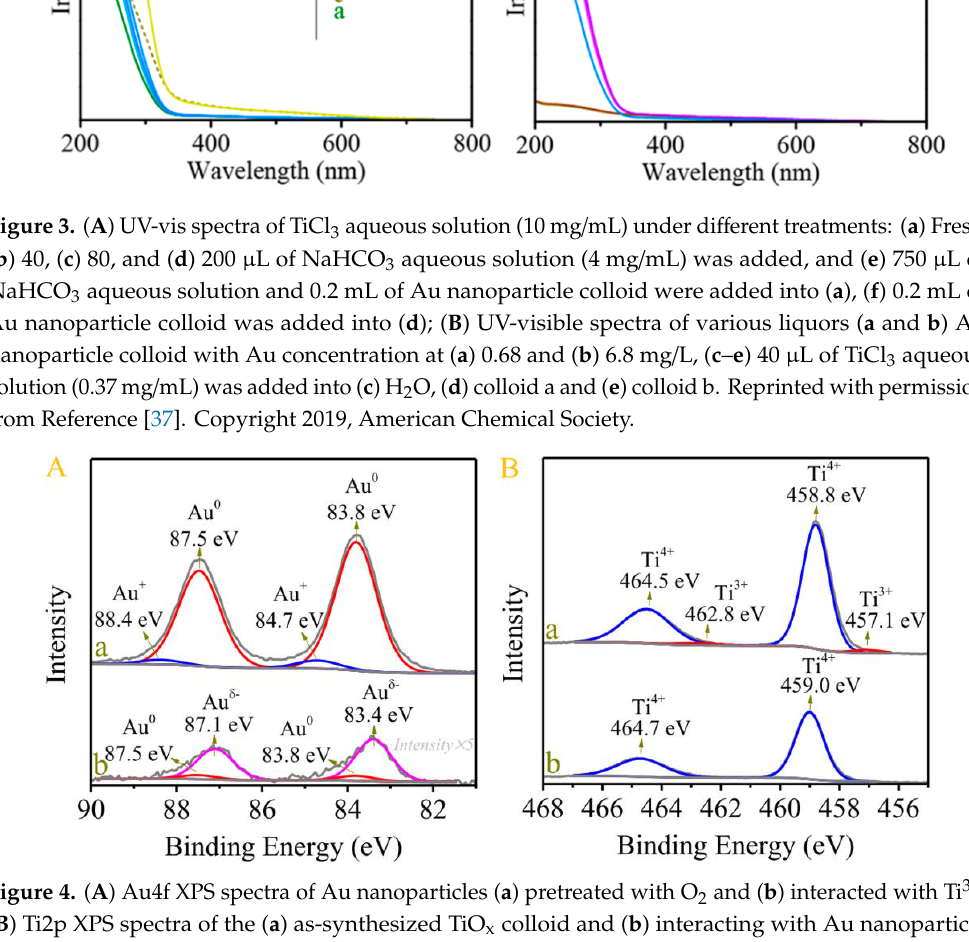
Figure 4. ( A ) Au4f XPS spectra of Au nanoparticles ( a ) pretreated with O 2 and ( b ) interacted with Ti 3+ ; ( B ) Ti2p XPS spectra of the ( a ) as-synthesized TiO x colloid and ( b ) interacting with Au nanoparticle colloid. Reprinted with permission from Reference [37]. Copyright 2019, American.